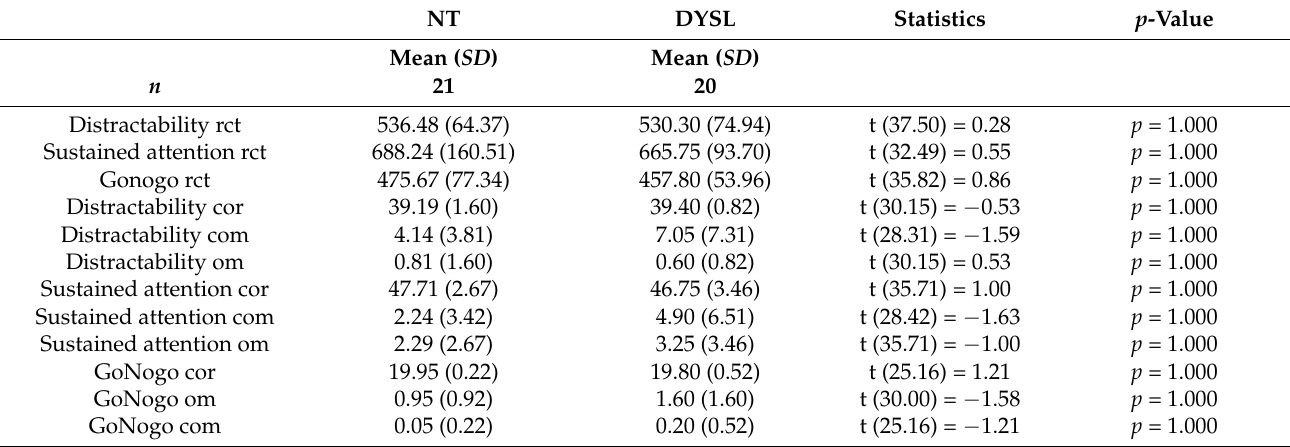
Table 3. Attention